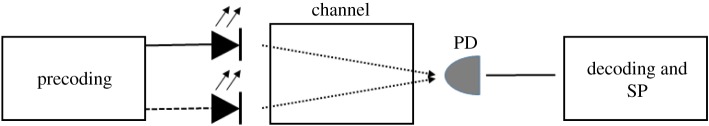
MA-SP configuration.